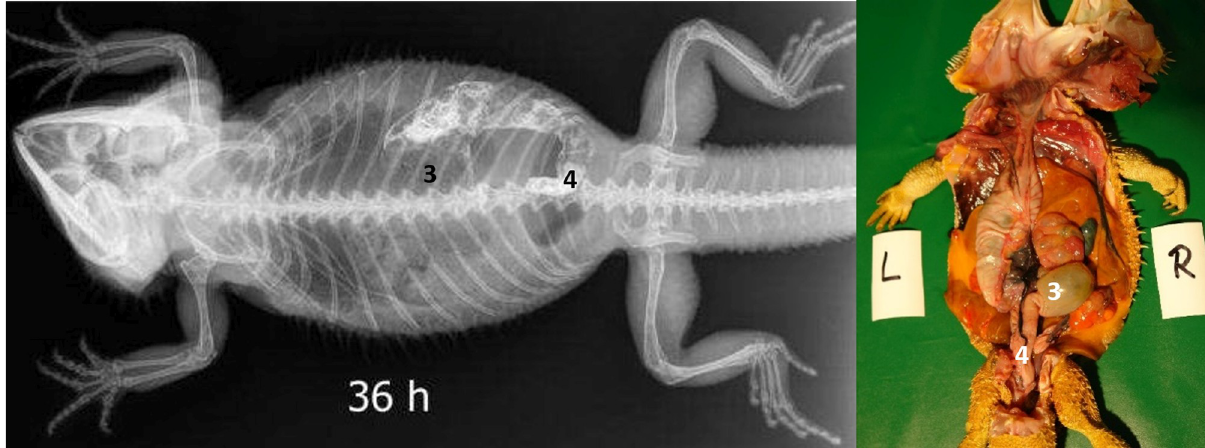
Fig 16. Dorsoventral (DV) radiograph 36 hours after oral administration of BaSO 4 . 36 hours after oral administration of BaSO 4 , (kV 42, mAs 2). The BaSO 4 has passed through the ampulla coli (3) and into the rectum (4), which has an “U-shape” and is located on the right side of the coelomic cavity running parallel to the spinal